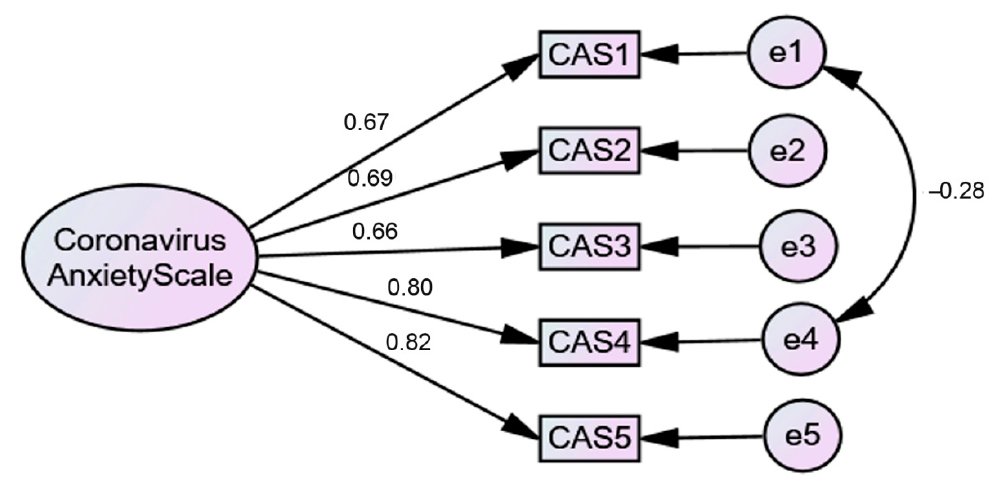
Figure 1. One-factor CFA model.